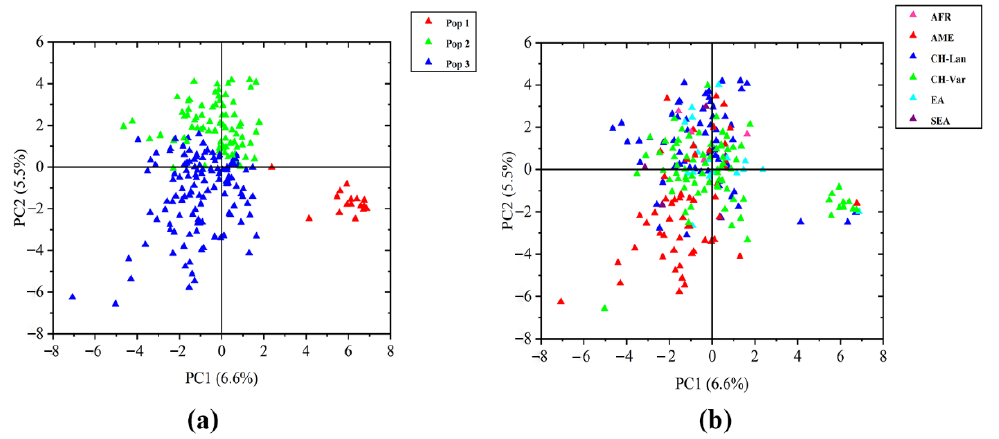
Figure 2. Principal component analysis of 240 accessions based on 30 InDel markers. ( a ) The coloration of each variety was determined by the results of the population structure (Pop1 = red, Pop2 = green, and Pop3 = blue). ( b ) Each accession was colored according to its geographical origin (CH-Lan, landraces in China; CH-Var, improved varieties in China; AME, from the CIP, the USA, and Brazil; EA, from the Asian Vegetable Research and Development Centre, Japan, and Korea; AFR, from the International Institute of Tropical Agriculture, and Morocco; SEA, from Indonesia, Philippines, Cambodia, and Vanuatu. CH-Lan = blue, CH-Var = green, AME = red, EA = bright blue, AFR = pink, SEA = purple).